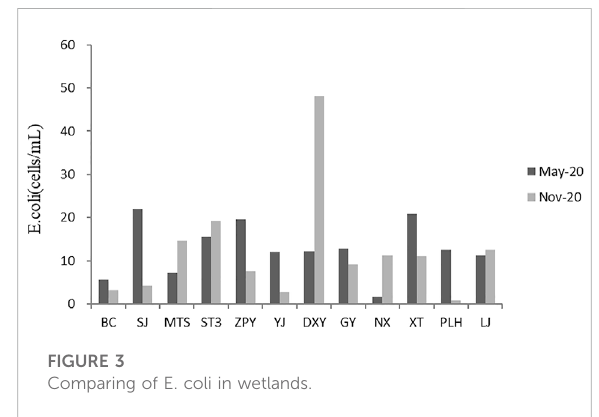
FIGURE 3 Comparing of E. coli in